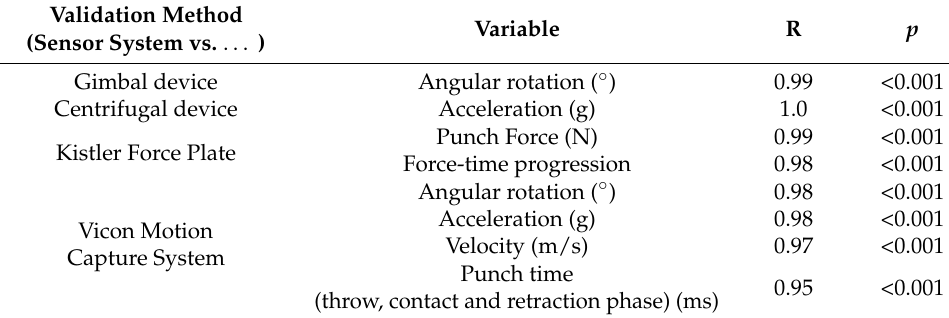
Table 3. Validation